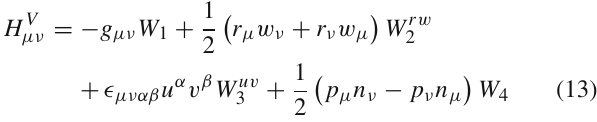
Fig. 3 Representation of the momentum and spin vectors in the laboratory frame. The left panel depicts the electron and positron momenta, respectively, (cid:4) p − and (cid:4) p + , their respective transverse spin vectors (cid:4) s − and (cid:4) s + , which lie along the positive and negative x -axis, respectively, the momentum (cid:4) p of the detected particle and the spin-quantization axis that is denoted by (cid:4) s . The right panel depicts the three different spin-quantization axes (cid:4) s , (cid:4) n and (cid:4) t defined in the text. In both panels, the axes x (cid:3) and y (cid:3) denote axes obtained by rotation of the x and y axes about the z axes through an angle φ